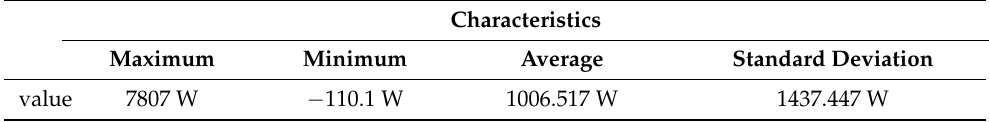
Table 1. Main characteristics of the target variable.